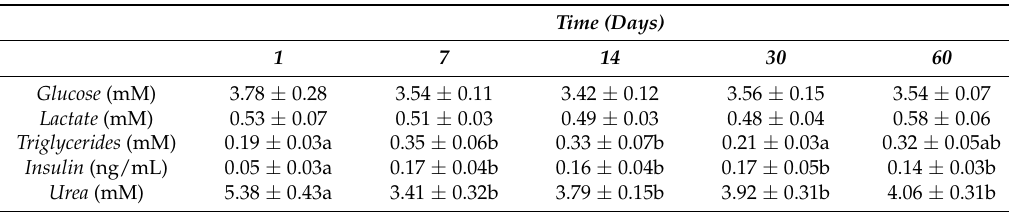
Table 1. Plasma fasting metabolites in Yucatan minipigs fed a high fat–high sucrose diet (HFHS) over 2